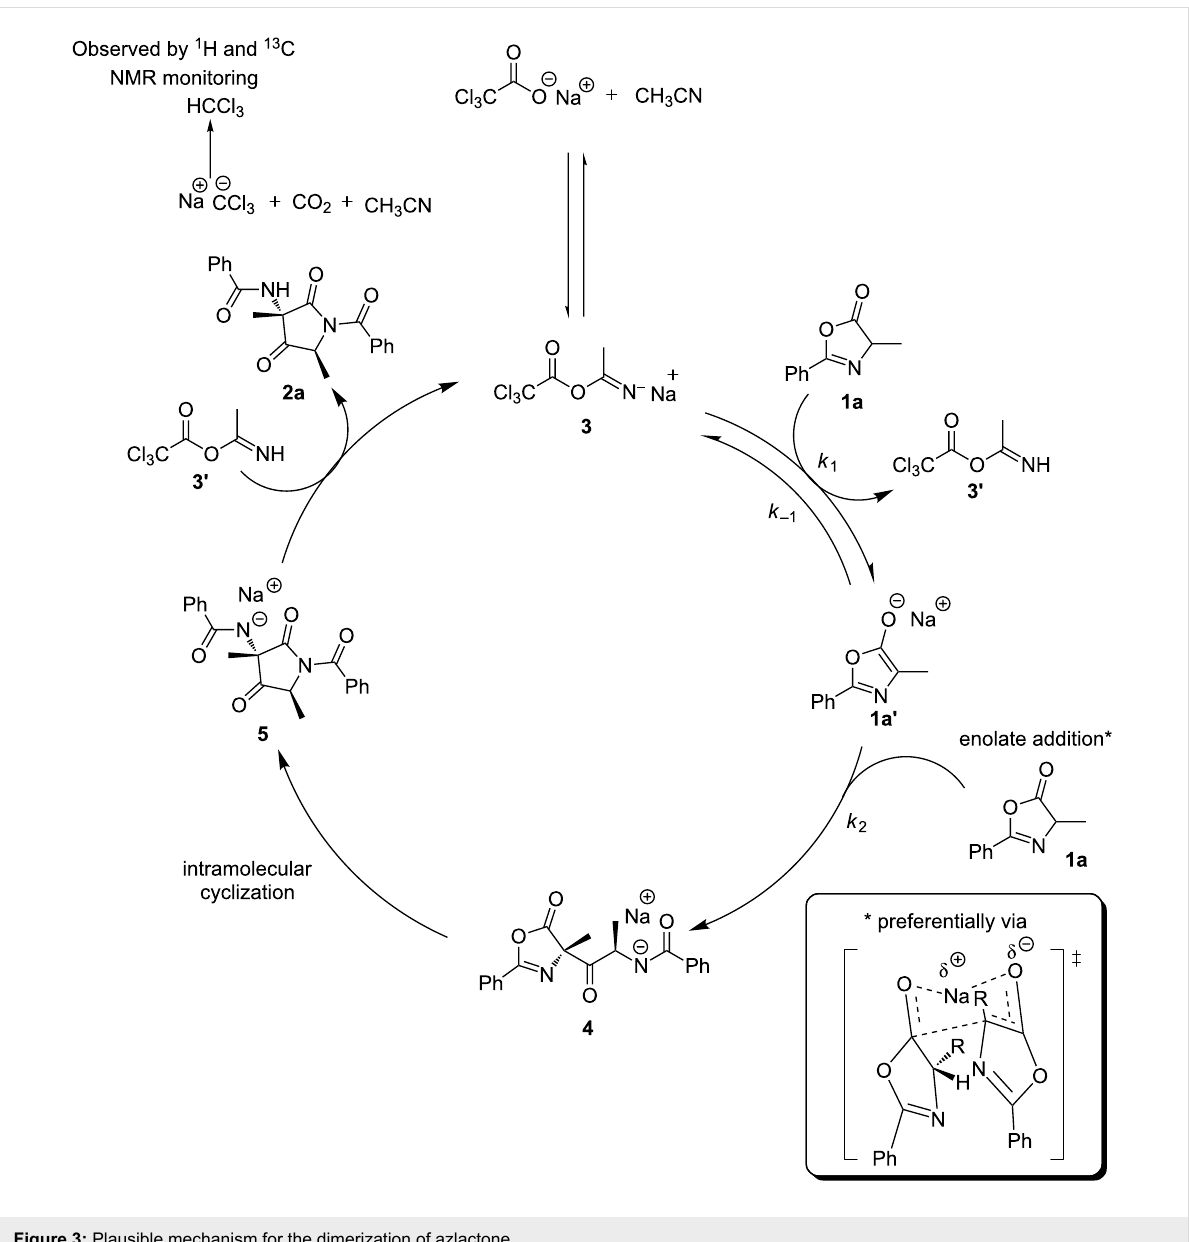
Figure 3: Plausible mechanism for the dimerization of azlactone.